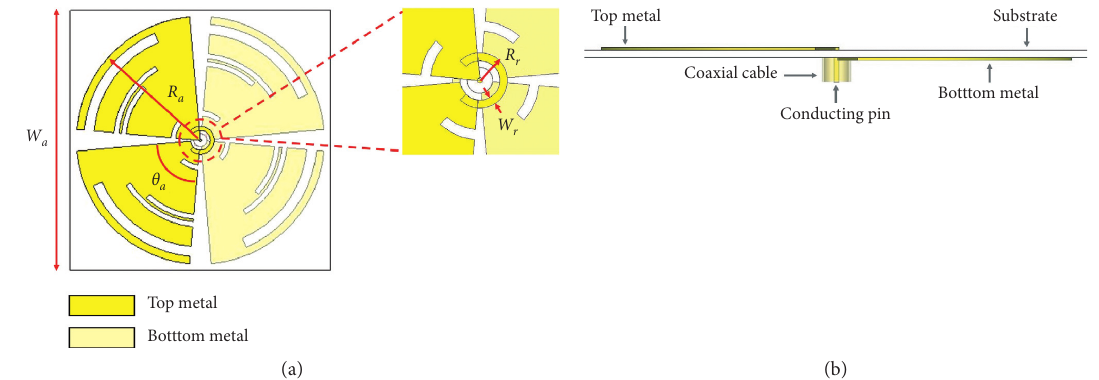
Figure 10: Proposed antenna design. (a) Front view. (b) Side view.